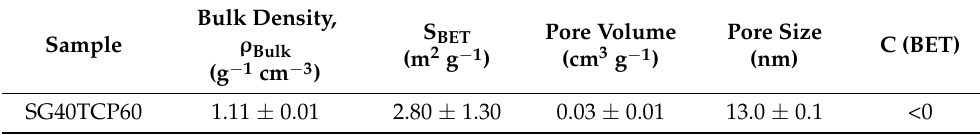
Table 1. Bulk density and textural data from N 2 physisorption experiments for the SG40TCP60 material used in scaffold manufacture by robocasting and laser